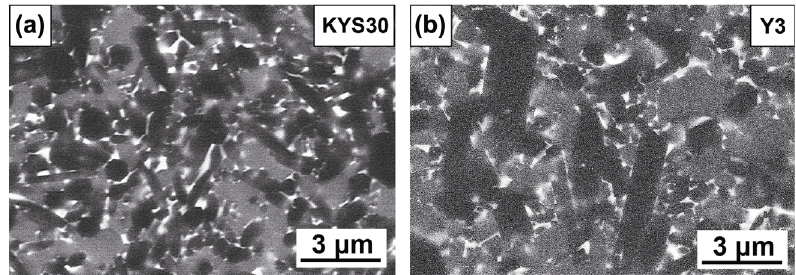
Fig. 15 Microstructure of commercial and microwave-synthesized α / β -SiAlON ceramic cutting inserts obtained under SEM–BSE mode: (a) KYS30 and (b) Y3. Table 3 Comparison of commercial and microwave-synthesized α / β -SiAlON milling inserts c